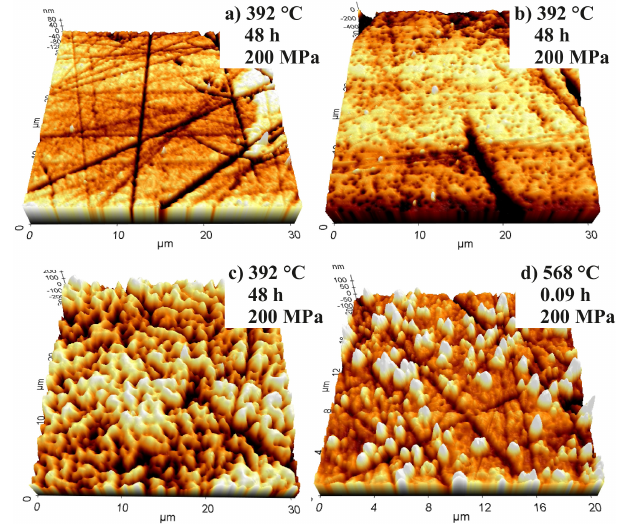
Figure 3. General surface characteristics of hydrothermally an- nealed samples as observed with AFM. The images represent dis- solution (first row) and growth structures (second row) for differ- ent crystallographic surfaces. (a) (cid:0) 10 ¯ 10 (cid:1) surface with scratches of different depths up to 70nm; (b) (cid:0) 10 ¯ 11 (cid:1) surface with holes (10 to 50nm). Growth structure: (c) selected pocks with partly idiomor- phic shapes found at low-lying grains of a sample that did not expe- rience extended hydrothermal annealing after reaching the indicated run conditions (P48, see Table 2), (d) ( 0001 ) surface with strong roughness found at high-lying grains (relief differences range from 100 to 200nm). The images (a) , (b) and (d) represent measurements of a single sample (P57, see Table